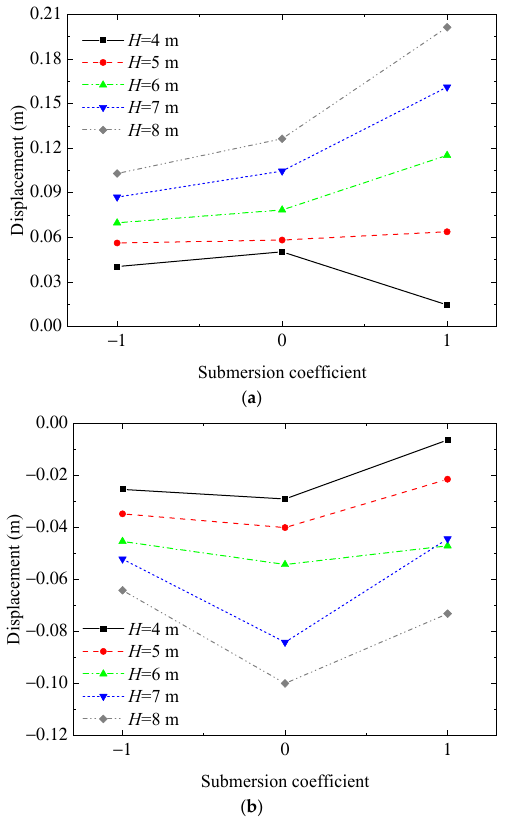
Figure 13. Comparison of the time histories of the displacement for Case K = 1042 kN/m. ( a ) Positive displacement; ( b ) Negative displacement.